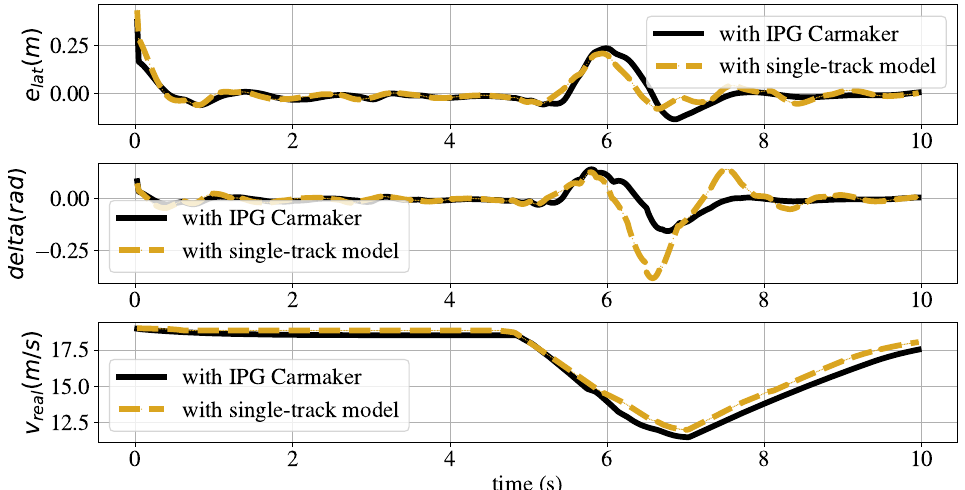
Figure 15. Comparison of the lateral error, the steering angle and the velocity of the ego vehicle for the two different simulation architectures in the construction scenario (extended ODD).